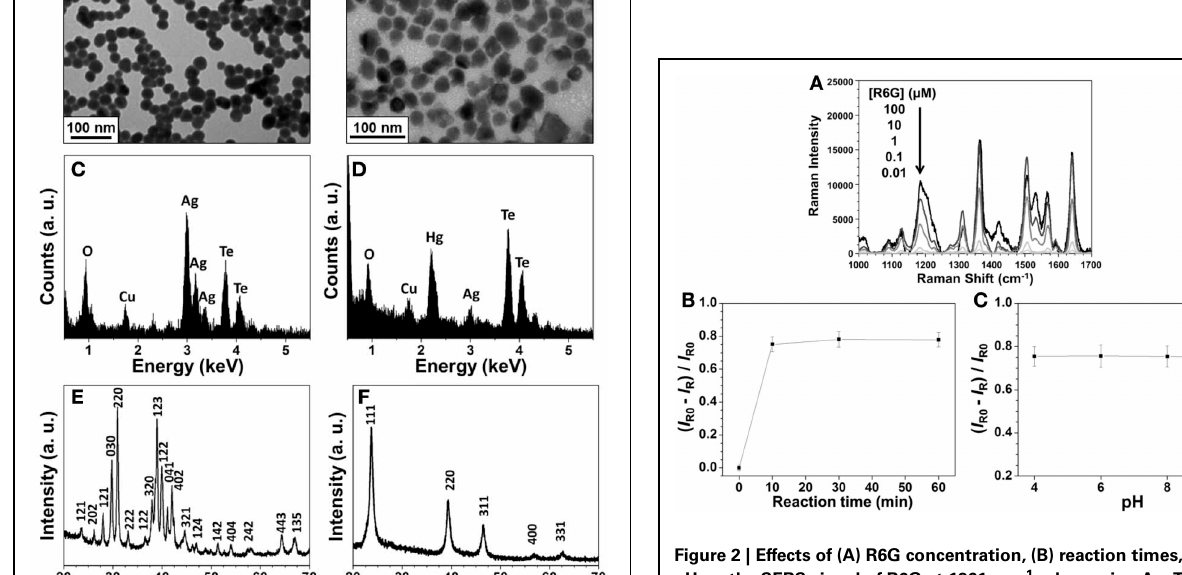
Figure 2 | Effects of (A) R6G concentration, (B) reaction times, and (C) pH on the SERS signal of R6G at 1361cm − 1 when using Ag 2 Te NPs as a substrate. The concentrations of Ag 2 Te NPs were both 0.001 × in (A) and (B) , of Hg 2 + were 0 in (A) and 100nM in (B) and (C) , and of R6G were both 10 µ M in (B) and (C) . The pH values were both 4.0 in (A) and (B) and reaction times were both 10min in (A) and (C) . I R 0 and I R are the SERS intensities of R6G at 1361cm − 1 in the absence and presence of Hg 2 + (100nM), respectively, in (B) and (C)